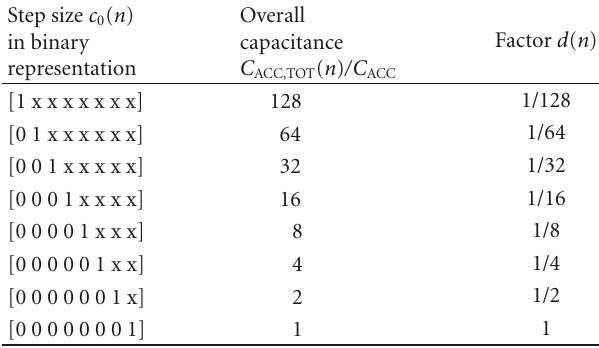
Table 2: Adaptation scheme for Q